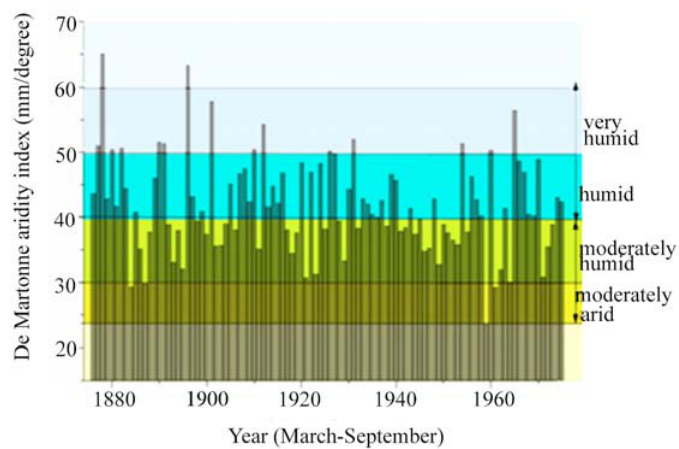
Fig. 4: Mean IDM for March-September and classification of the climate for 1875-1974 according to the temperature and precipitation data obtained from the Davos weather station